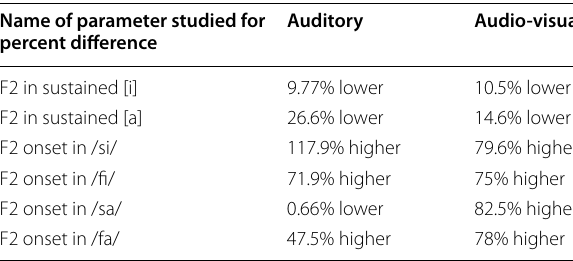
Table 7 Percent change in F2 of isolated [i] and [a] vowels and F2 onset in /si/, /fi/, /sa/, and /fa/ syllables in second compared to first evaluation in NLFC